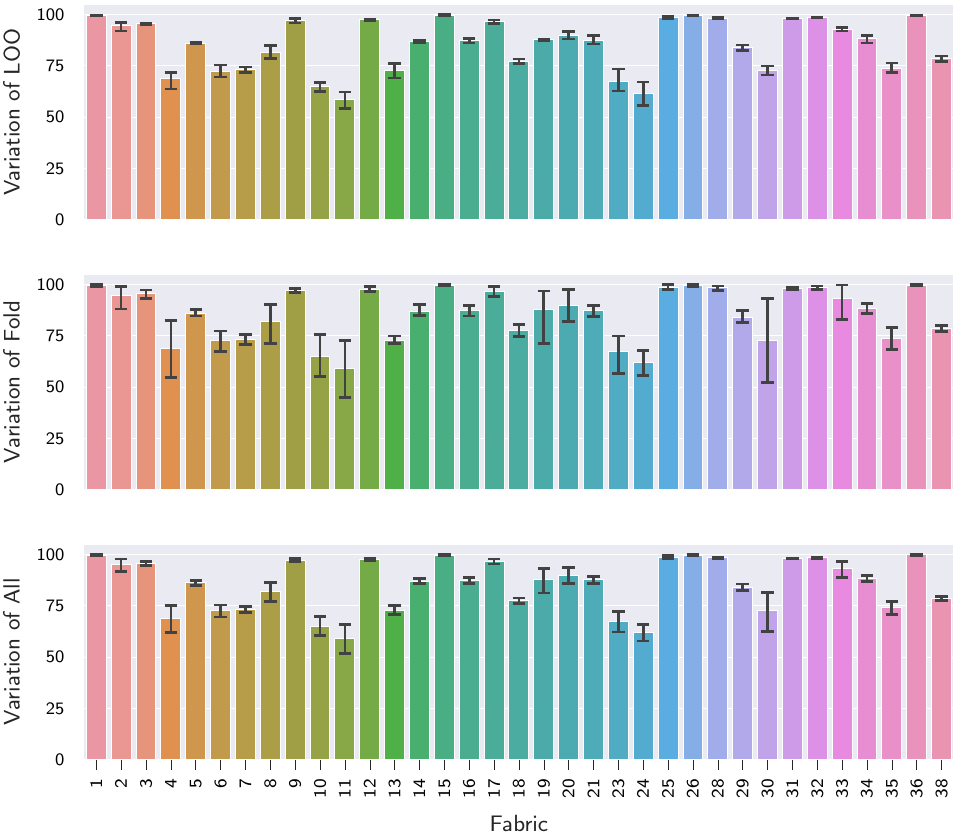
Figure 6. Variance decomposition of the LOO performance for an ImageNet pre-trained EfficientNet- B0 when combined with HSC loss and the application of AugMix. We show both mean and 95% CI for the AUPR on the unseen fabrics for all data points (Variation of All), as well as when first aggregating over the five LOO folds (Variation of Fold) and the five large-scale dataset folds (Variation of LOO),